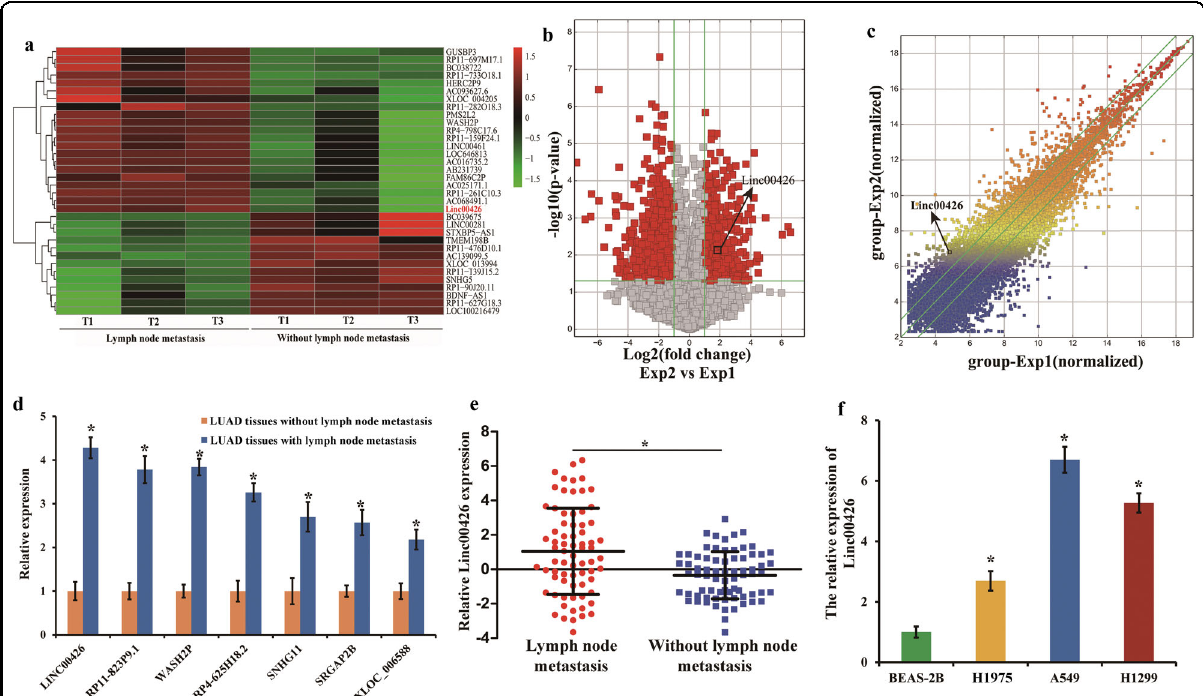
Fig. 1 Differential expression pro fi les of LncRNAs in LUAD tissues with and without lymph node metastasis. a Distinguishable LncRNA pro fi ling in LUAD tissues analyzed by hierarchical clustering (fold change ≥ 2; P < 0.05). Relative expression levels from high to low were indicated by red and green, respectively. b Volcano plots of LncRNAs. The red plots were differentially expressed LncRNAs with statistically signi fi cant difference (fold change ≥ 2, P < 0.05). c Variations in LncRNAs among LUAD tissues presented by scatter plots. d Relative expression of seven LncRNAs in LUAD tissues determined by RT-qPCR. Student ’ s t test. e Relative expression of Linc00426 in 72 LUAD tissues with lymph node metastasis and 72 LUAD tissues without lymph node metastasis determined by RT-qPCR. GAPDH serves as a reference gene for Linc00426. Results were presented as log2 fold lymph node metastasis tissues relative to without lymph node metastasis. Student ’ s t test. f Expression of Linc00426 in different LUAD cells and BEAS- 2B cells examined by RT-qPCR. One-way ANOVA. Experiments were performed three times and data were presented as mean ± SD. * P <